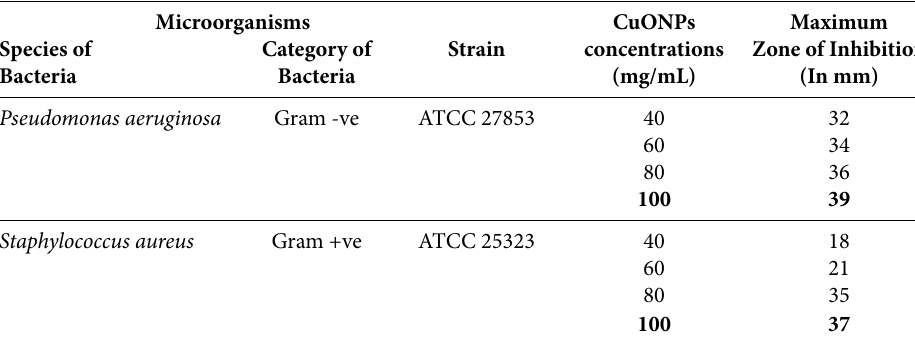
Table 2: Maximum zone of inhibition of different concentration of MMT-CuONC against Gram -ve and Gram +ve bacteria